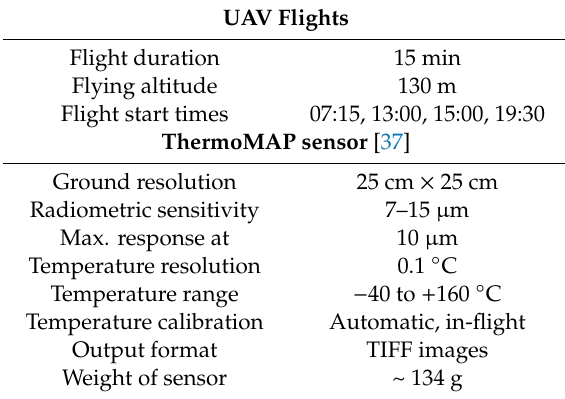
Table 1. Characteristics of unmanned airborne vehicle (UAV) flights and